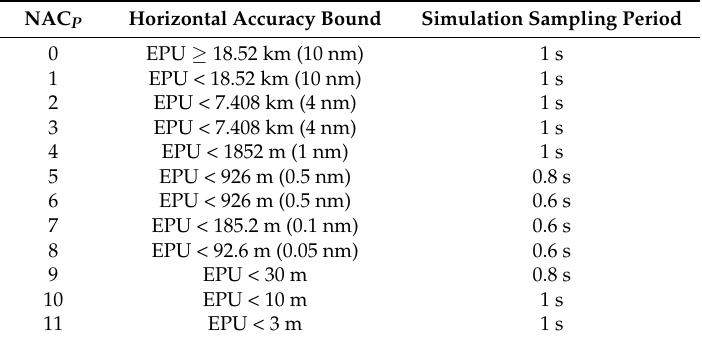
Table 1. Simulation sampling period corresponding to different Navigation Accuracy Category for Position (NAC P ) values. NAC